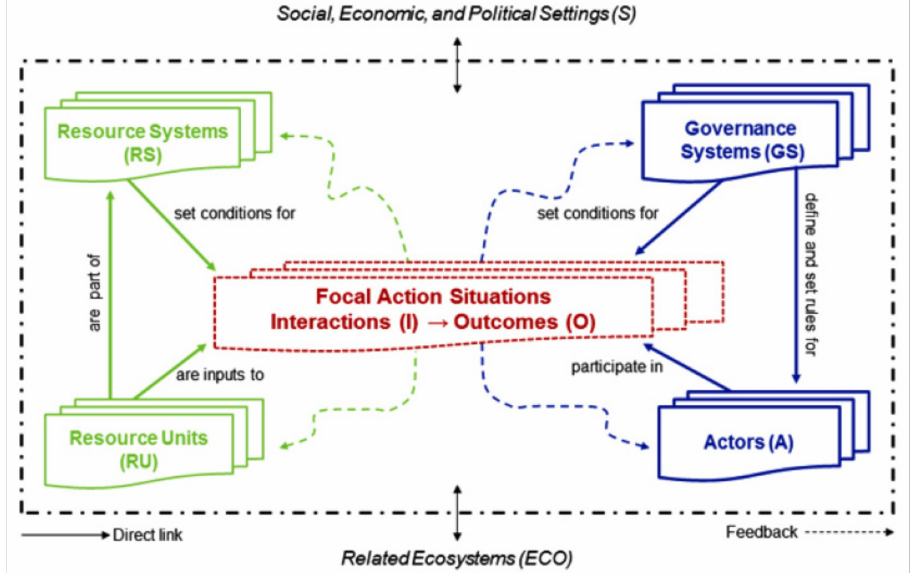
Figure 1. Social-ecological system (SES) framework. Source: